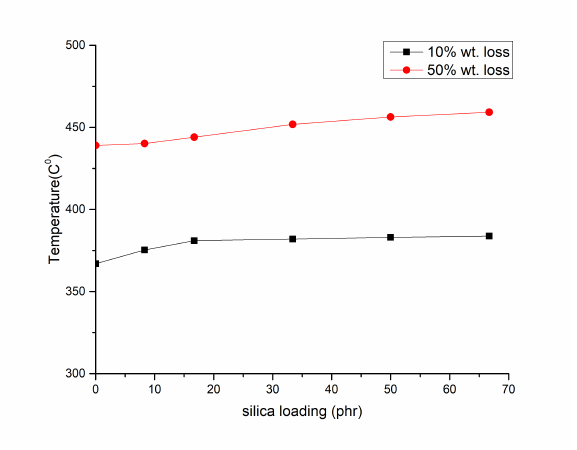
Figure 6: Temperature at 10 % and 50% wt. loss with respect silica